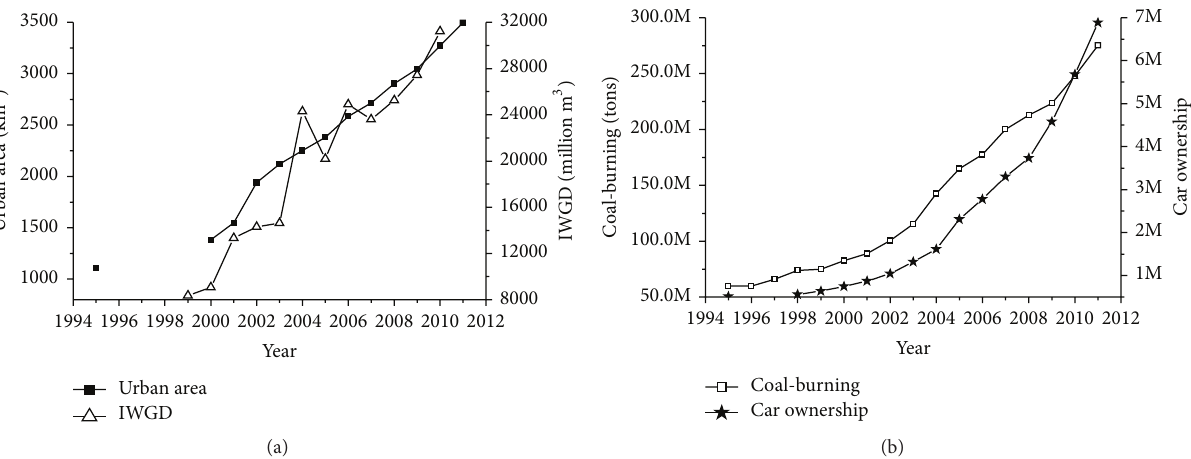
Figure 8: The socioeconomic indicators in Jiangsu Province ((a): urban area and industrial waste gas discharge; (b): coal-burning and car